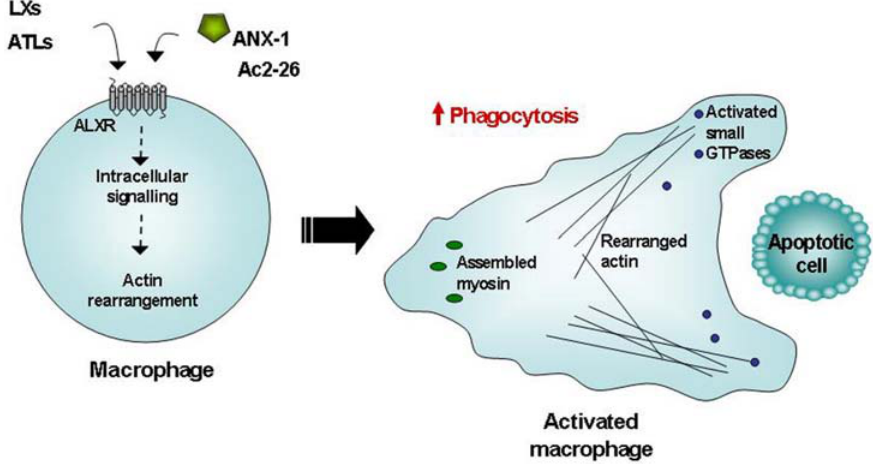
FIGURE 3. Phagocytosis of apoptotic cells by M φ is augmented by ligands of the LX receptor (ALXR). LXs and ATLs, annexin-1 (ANX-1), and its N-terminal fragment Ac2-26, interact with the ALXR on the macrophage leading to intracellular signaling events, including activation of the small GTPases RhoA, Rac, and Cdc42, myosin assembly and actin rearrangement, priming the M φ for the phagocytosis of apoptotic cells.